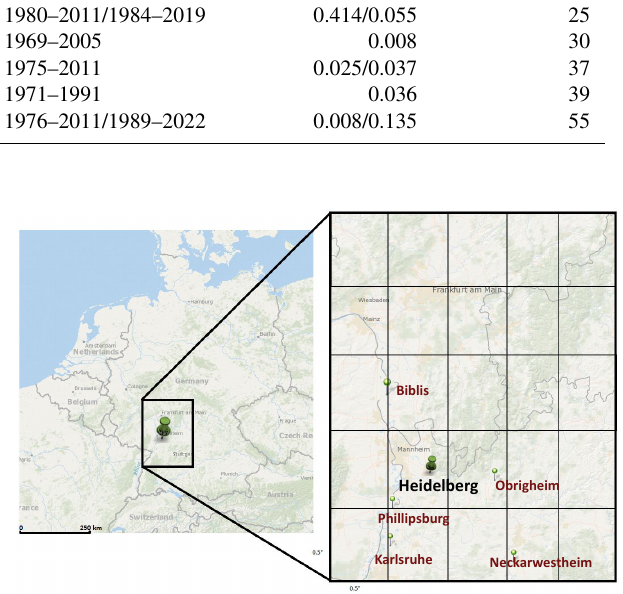
Figure 1. Map of the Heidelberg sampling site in southwest Ger- many. The locations of the five nearest nuclear facilities are shown in the enlargement. This enlargement corresponds to the size of the 2.5 ◦ × 2.5 ◦ wind field grid. The 0.5 ◦ × 0.5 ◦ wind field resolution is indicated by the grid in the